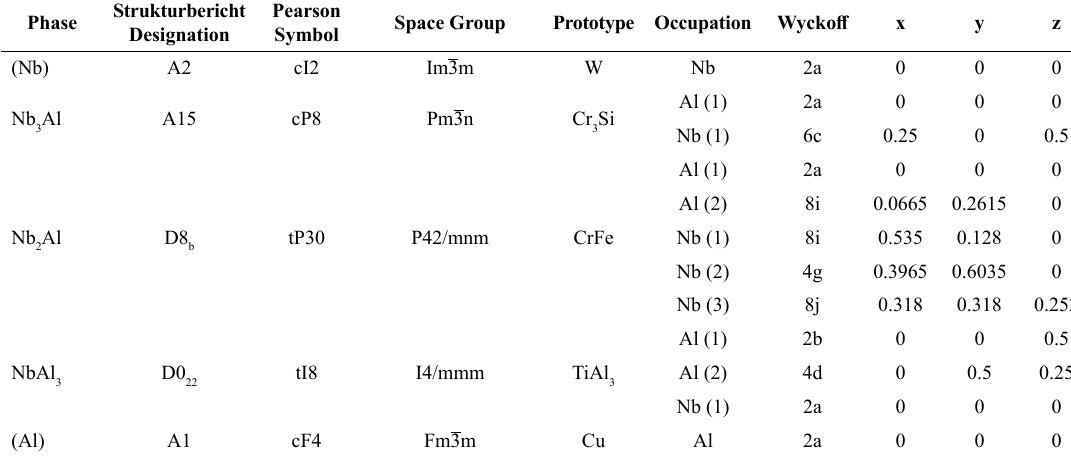
Table 2. Crystallographic information of stable solid phases of the Nb-Al system 40 .